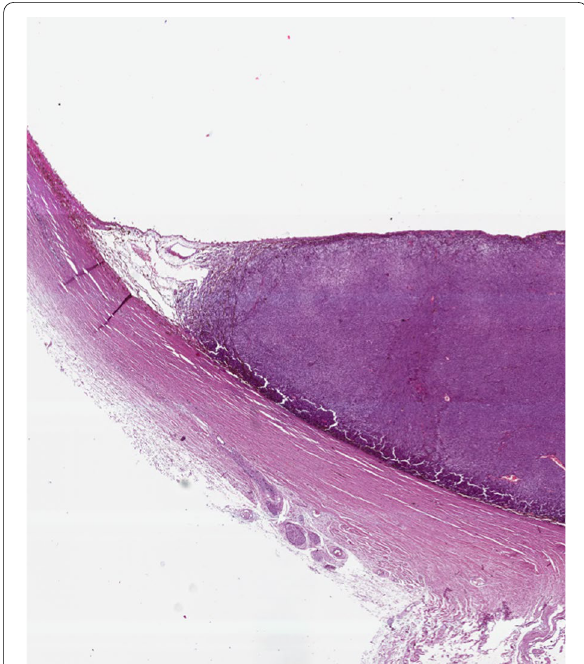
Fig. 10 Histological examination demonstrating a melanoma originating from the choroid that raises up the retina (H&E, original magnification ×